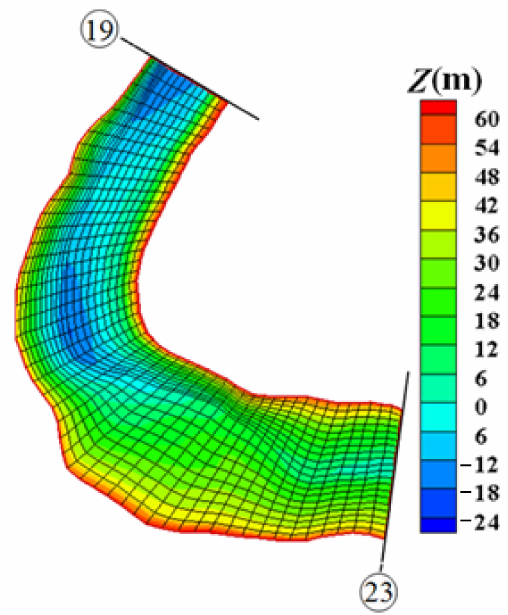
Figure 11. Terrain colored map based on